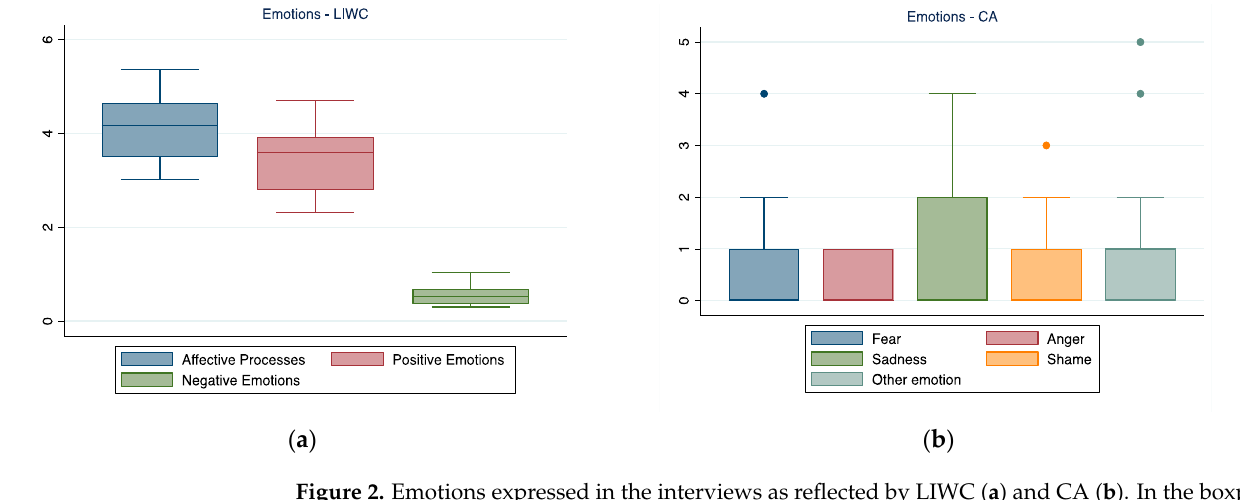
Figure 2. Emotions expressed in the interviews as reflected by LIWC ( a ) and CA ( b ). In the boxplot, the central horizontal line indicates the median, the other two lines indicate the first (lower line) and third (higher line) quartiles, the whiskers indicate the minimum and maximum values, and the dots indicate outliers.